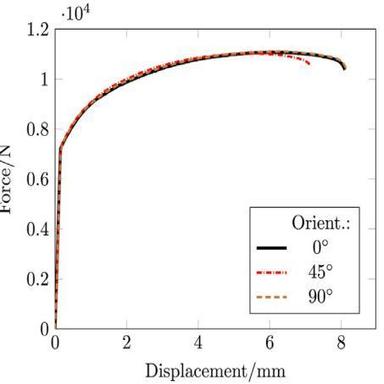
Measured loading force and displacement for the three notched specimens.